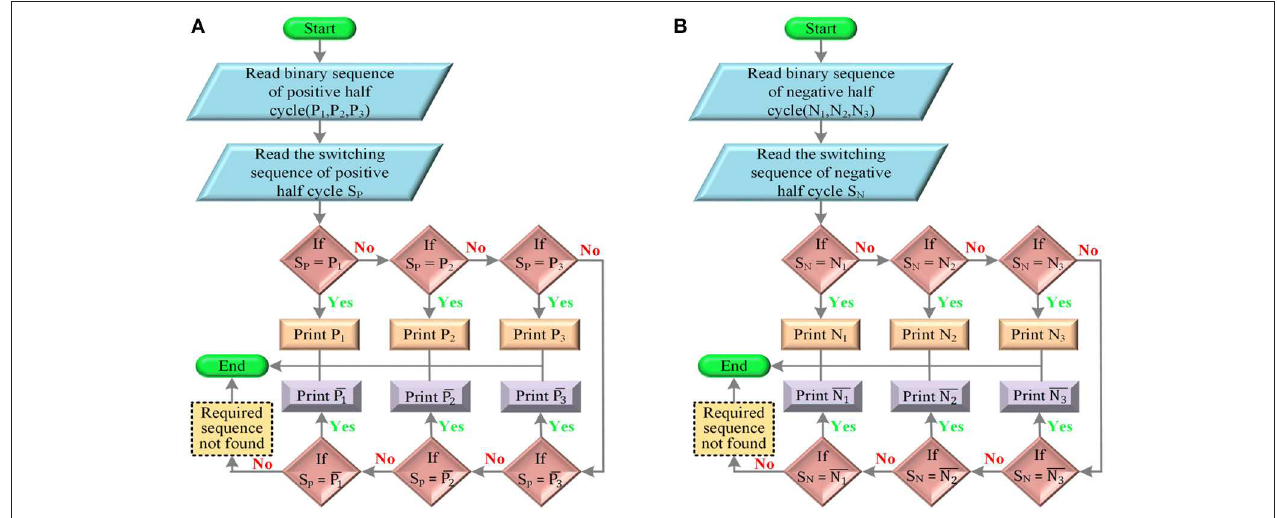
FIGURE 4 | Flowchart for selecting the single-variable pulse sequence. (A) Positive switching sequence. (B) Negative switching sequence.